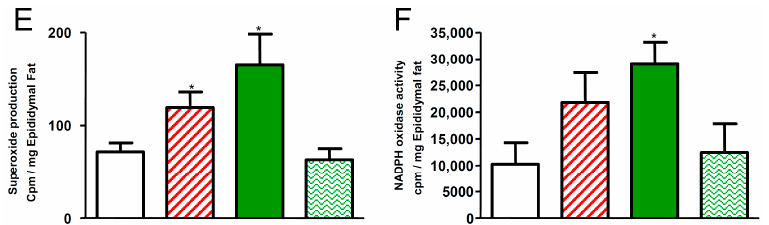
Figure 6. Effects of 12 weeks of glucose feeding combined or not with orally and daily administered (5 mL·kg − 1 ) corn oil or argan oil on ( A ) superoxide anion production expressed in cpm·mg − 1 of thoracic aorta, ( B ) NADPH oxidase activity expressed in cpm·mg − 1 of thoracic aorta, ( C ) superoxide anion production expressed in cpm·mg − 1 of gastrocnemius muscle, ( D ) NADPH oxidase activity expressed in cpm·mg − 1 of gastrocnemius muscle, ( E ) superoxide anion production expressed in cpm·mg − 1 of epididymal fat and ( F ) NADPH oxidase activity expressed in cpm·mg − 1 of epididymal fat. Values are the mean ± SEM of 4–6 rats per group.* p < 0.05 vs. control, # p < 0.05 vs. glucose, + p < 0.05 vs. glucose + corn oil.